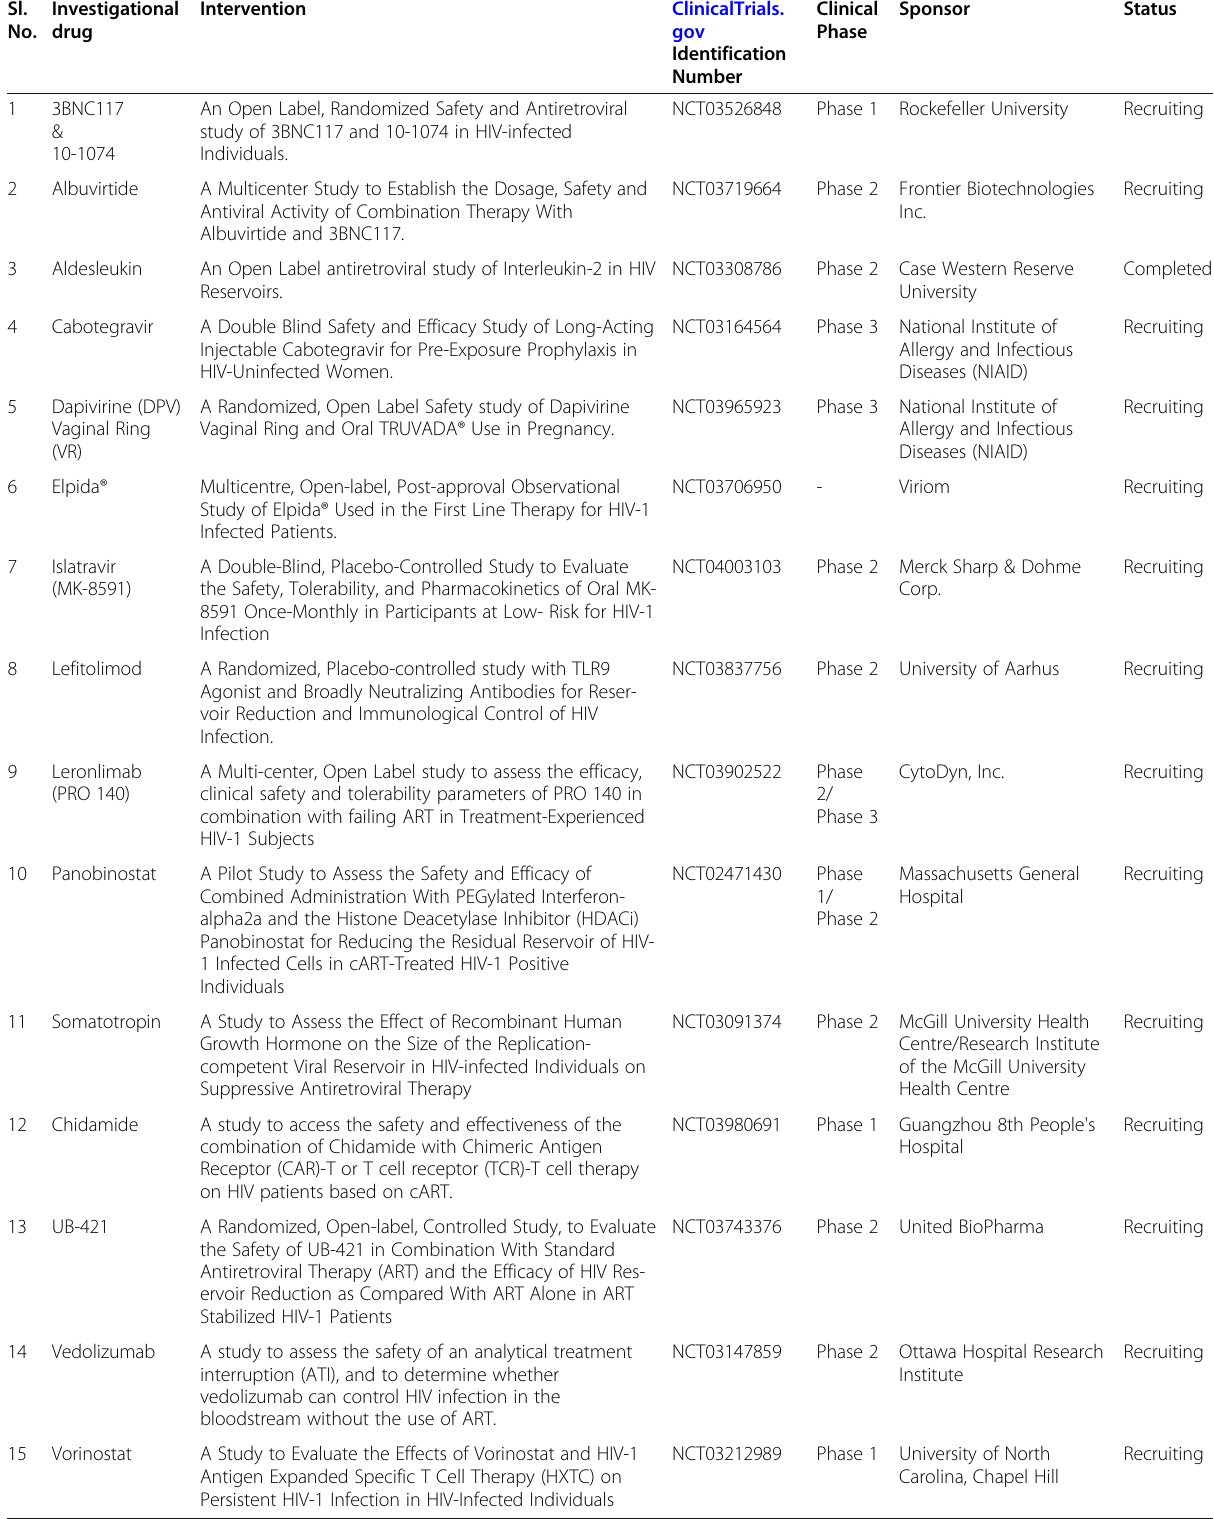
Table 2 Investigational antiretroviral drugs in clinical trial